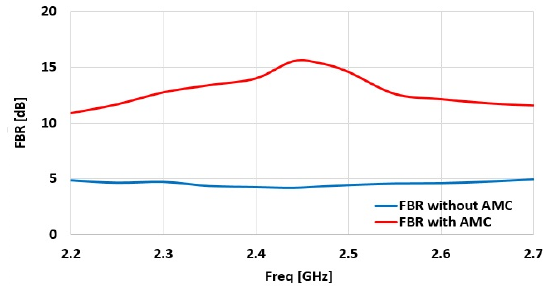
FIGURE 8. Front to Back Ratio (FBR) of the proposed antenna with and without AMC structure